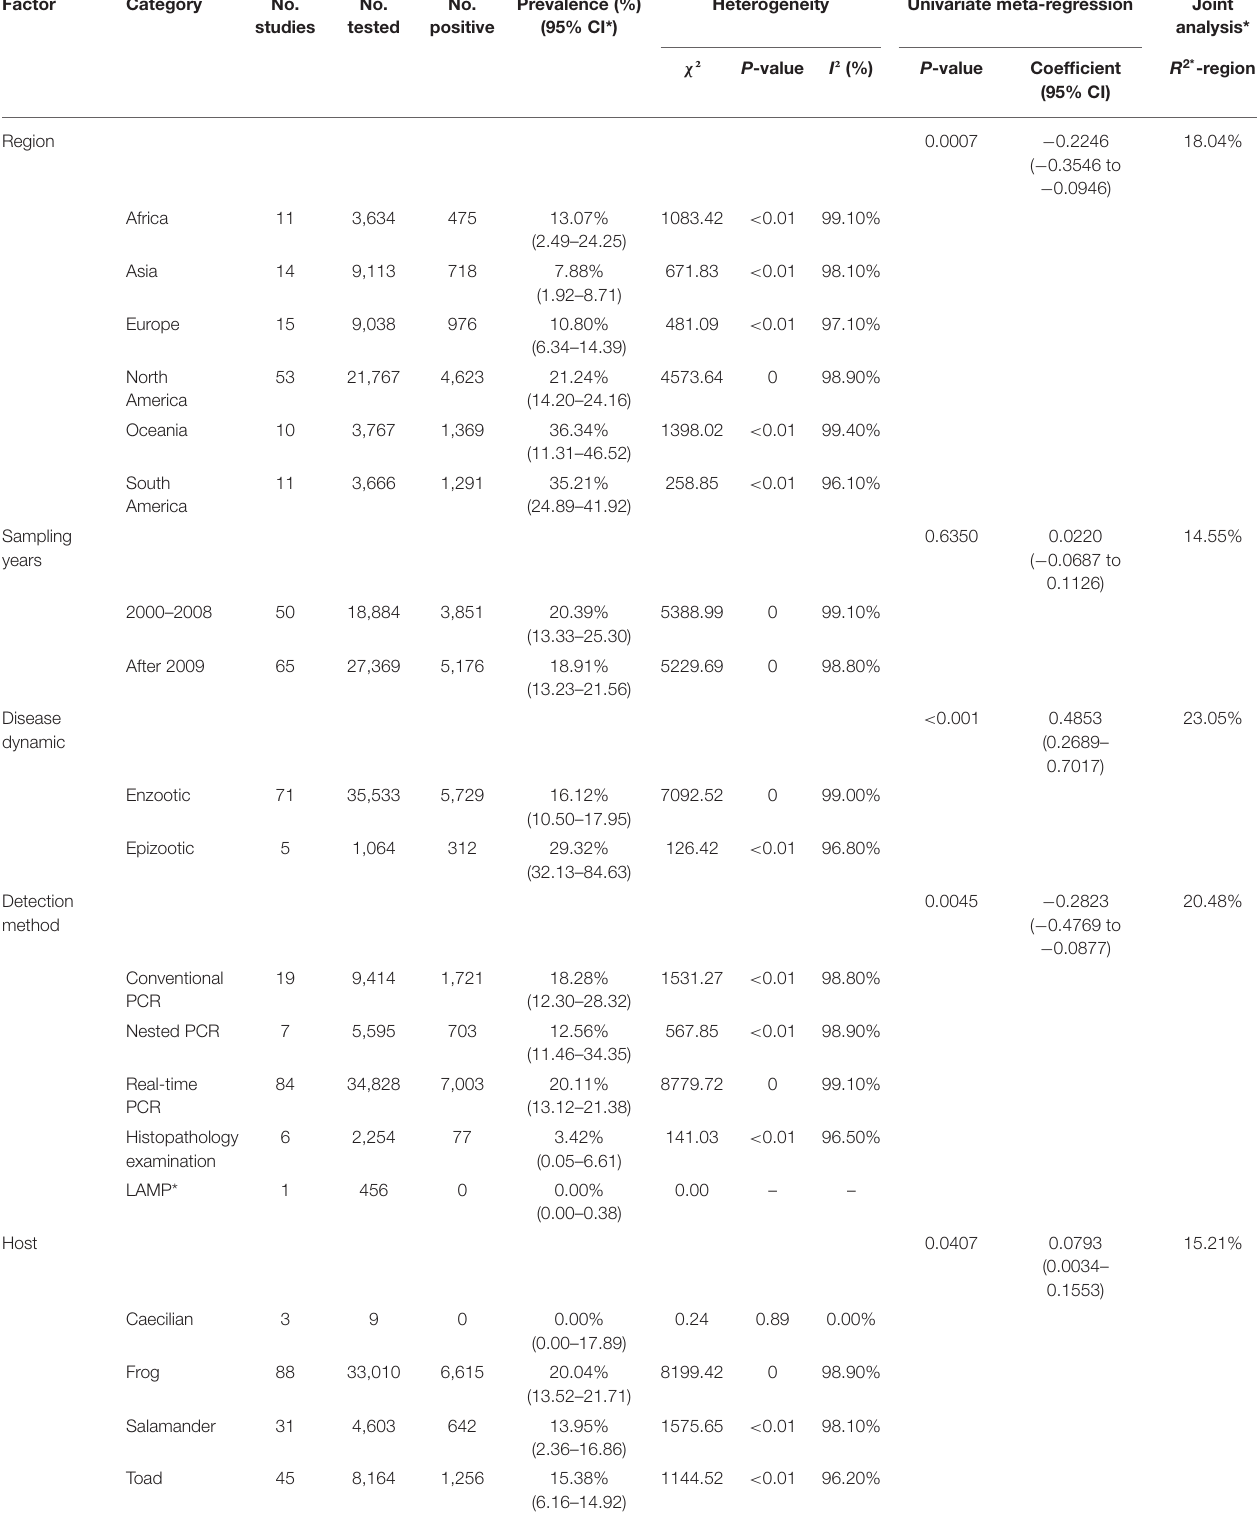
TABLE 1 | Pooled worldwide prevalence of Batrachochytrium dendrobatidis by region.